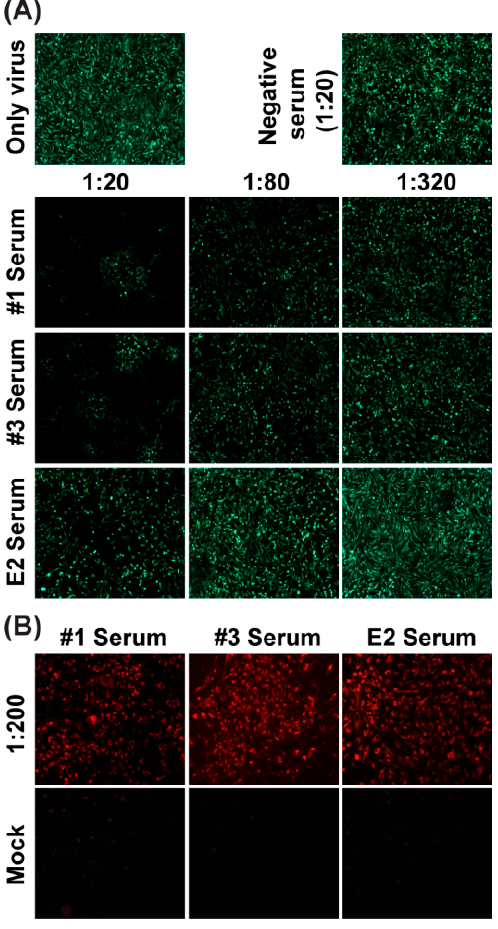
Figure 7. Neutralization assay with sera from mice using eGFP-CHIKV. ( a ) detection of eGFP expression by fluorescent microscope with different dilutions of sera from mice immunized with different antigens. #1 and #3 sera were from two mice immunized with formalin-inactivated CHIKV, and anti-E2 serum was obtained from one mouse immunized with SDS-PAGE purified CHIKV E2 protein. NT assay was performed as described for CHIKV-infected patient sera; ( b ) the reactivity of the tested sera against CHIKV through an IFA. All three sera (#1, #3 and E2 sera) were diluted at 1:200. Mock and CHIKV infected BHK-21 cells were used to performed IFA.